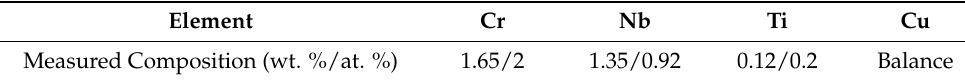
Table 1. The chemical composition of the Cu–Cr–Nb–Ti alloy powders. Element Cr Nb Ti Cu Measured Composition (wt. %/at. %) 1.65/2 1.35/0.92 0.12/0.2